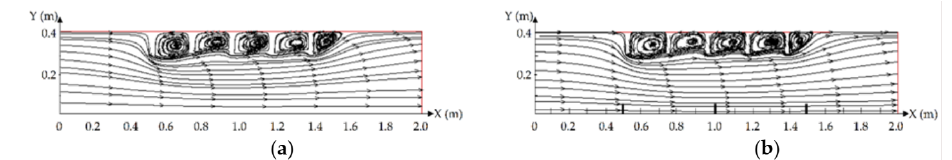
Figure 10. Overview of the simulated flow fields around multiple spur dikes in the experimental case: ( a ) case G4a and ( b ) case G5a.